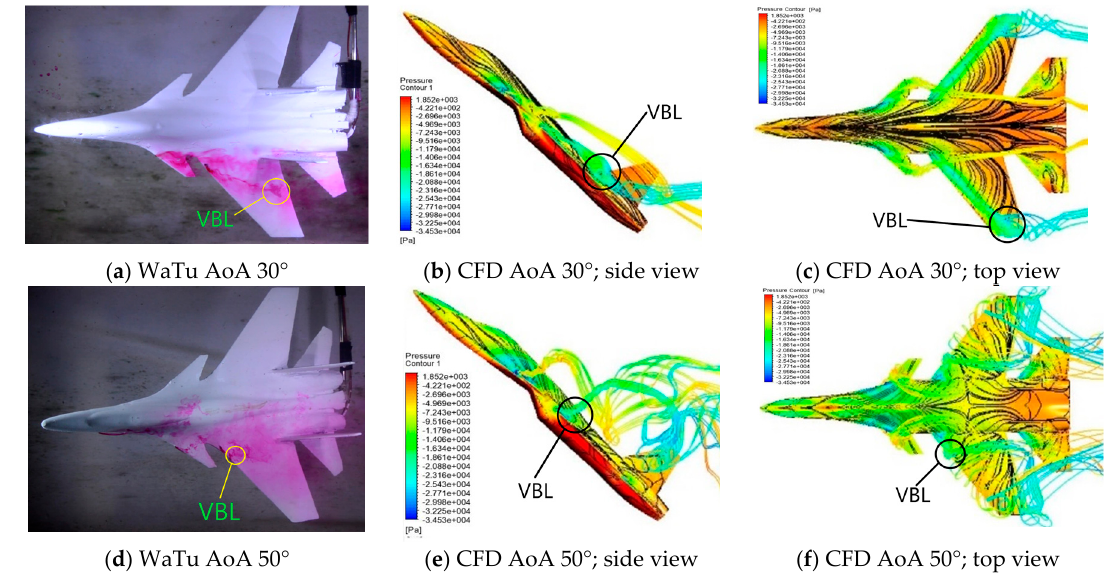
Figure 2. The results of flow visualization and vortex breakdown location (VBL) using water tunnel (WaTu) and computational fluid dynamics (CFD) in standard deflection configuration δ = 0°. AoA = angles of attack.